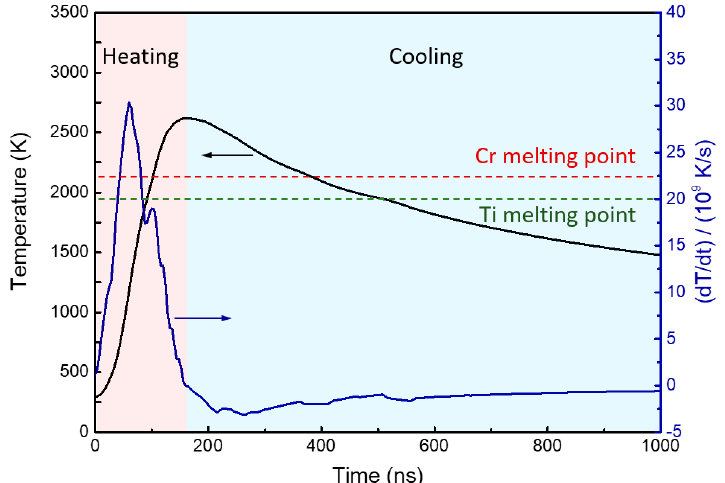
Figure 3. Variations in temperature and temperature change rate with time at a depth of 400 nm (interface between film and substrate).